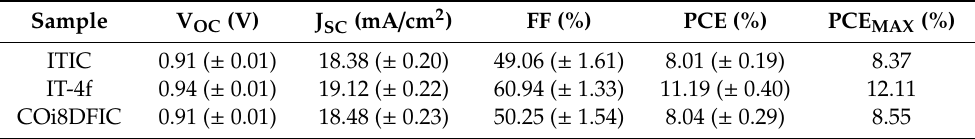
Figure 2. ( a ) Typical current density–voltage (J–V) curves and ( b , c ) statistical photovoltaic cell parameters of the PSC with various ETMs under optimal concentration conditions. Table 1. Summary of statistical photovoltaic cell parameters of the PSC with various ETMs under optimal concentration conditions.